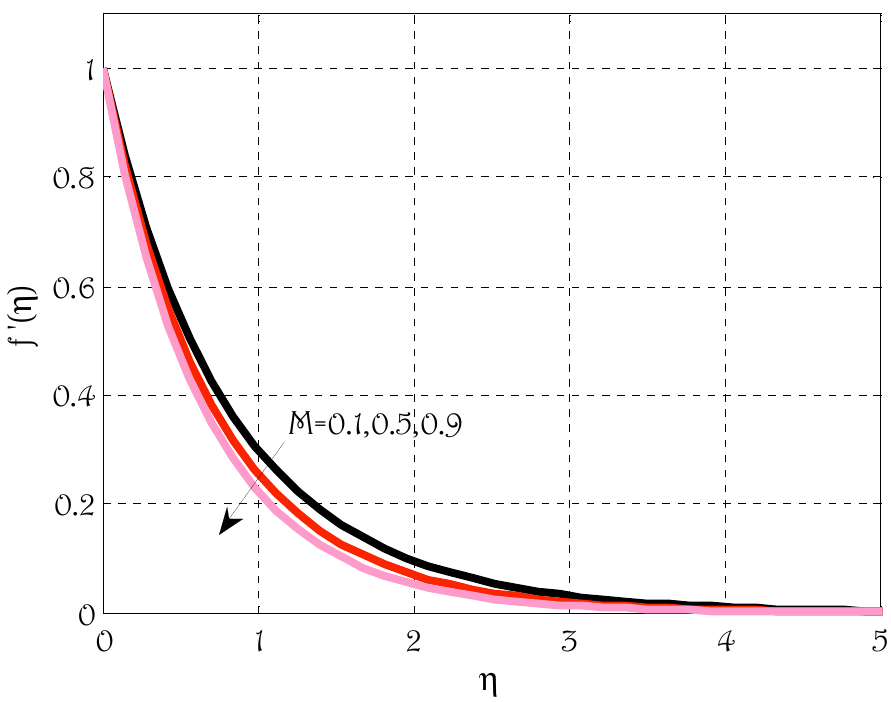
Figure 2. Effect of magnetic parameter M on velocity profile f (cid:48) using λ = 0.1, k p = 0.1, R d = 0.7, P r = 1.9, E c = 0.1, N b = 0.1, N t = 0.1, S c = 1.4, γ = 0.1.